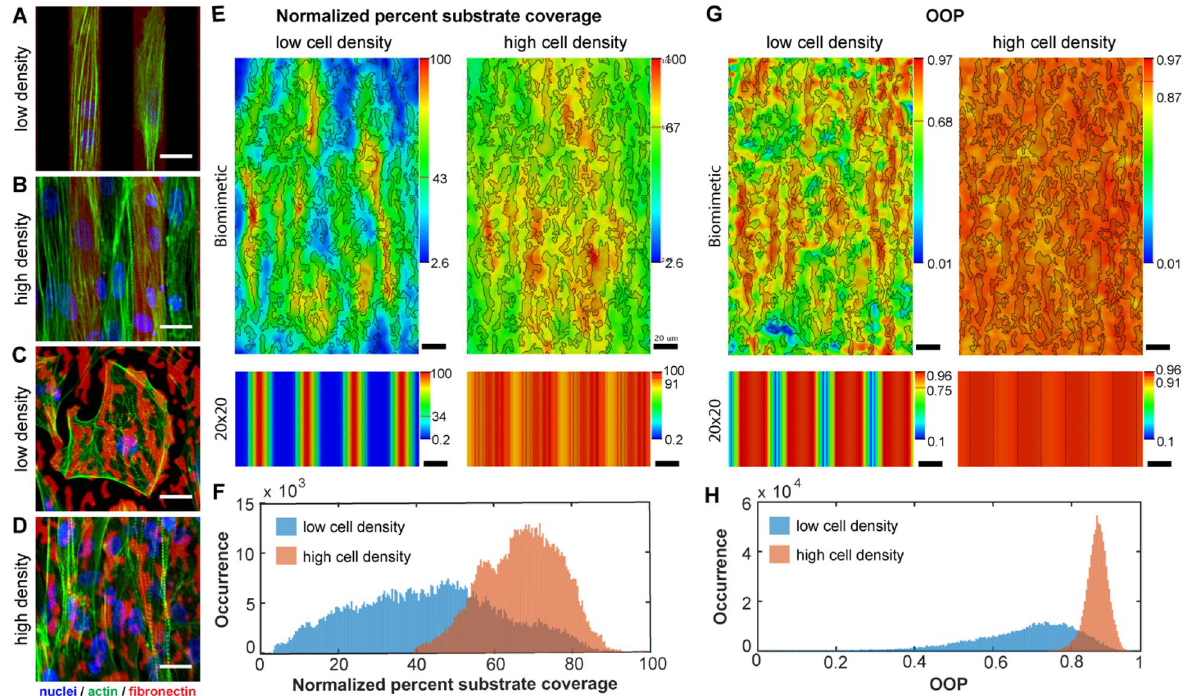
Figure 3. Analysis of sub-cellular differences in embryonic chick cardiomyocyte adhesion and alignment to the biomimetic and 20 × 20 fibronectin micropatterns as a function of cell density. ( A ) At low density, chick cardiomyocytes adhere and align directly to the 20 × 20 fibronectin lines due to spatial confinement and the inability to bridge across lines. ( B ) At high density, chick cardiomyocytes are able to bridge the 20 × 20 lines to form a confluent monolayer that is still aligned. ( C ) At low density, chick cardiomyocytes adhere to the various features in the biomimetic pattern and are not well aligned. ( D ) At high density, chick cardiomyocytes adhere to the entire surface of the biomimetic pattern and are well aligned. ( E ) Heat maps of cell substrate coverage, showing the normalized occurrence of cardiomyocytes adhering to the biomimetic and 20 × 20 micropatterns at both low and high cell densities. ( F ) Histogram of substrate coverage for chick cardiomyocytes on the biomimetic pattern at low and high densities, indicating the normalized occurrence of a cell adhering to the biomimetic pattern, binned in to 1 µm 2 regions. ( G ) Heat maps of cell OOP, showing regional variation in cardiomyocyte alignment on the biomimetic and 20 × 20 micropatterns at both low and high cell densities. ( H ) Histogram of OOP for chick cardiomyocytes on the biomimetic pattern at low and high densities. Scale bars are 20 µm. Heat maps and orientation plots were generated with a custom MATLAB code (MATLAB 2017a, https:// www. mathw orks. com/ produ cts/ new_ produ cts/ relea se201 7a.